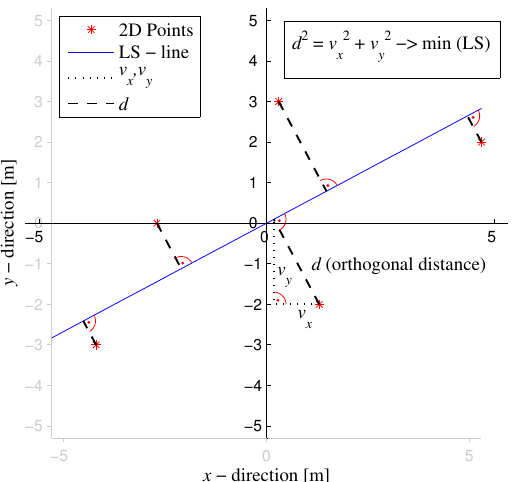
Figure 3: Example of fitting a straight line to a set of 2D points with coordinates reduced to the centre of